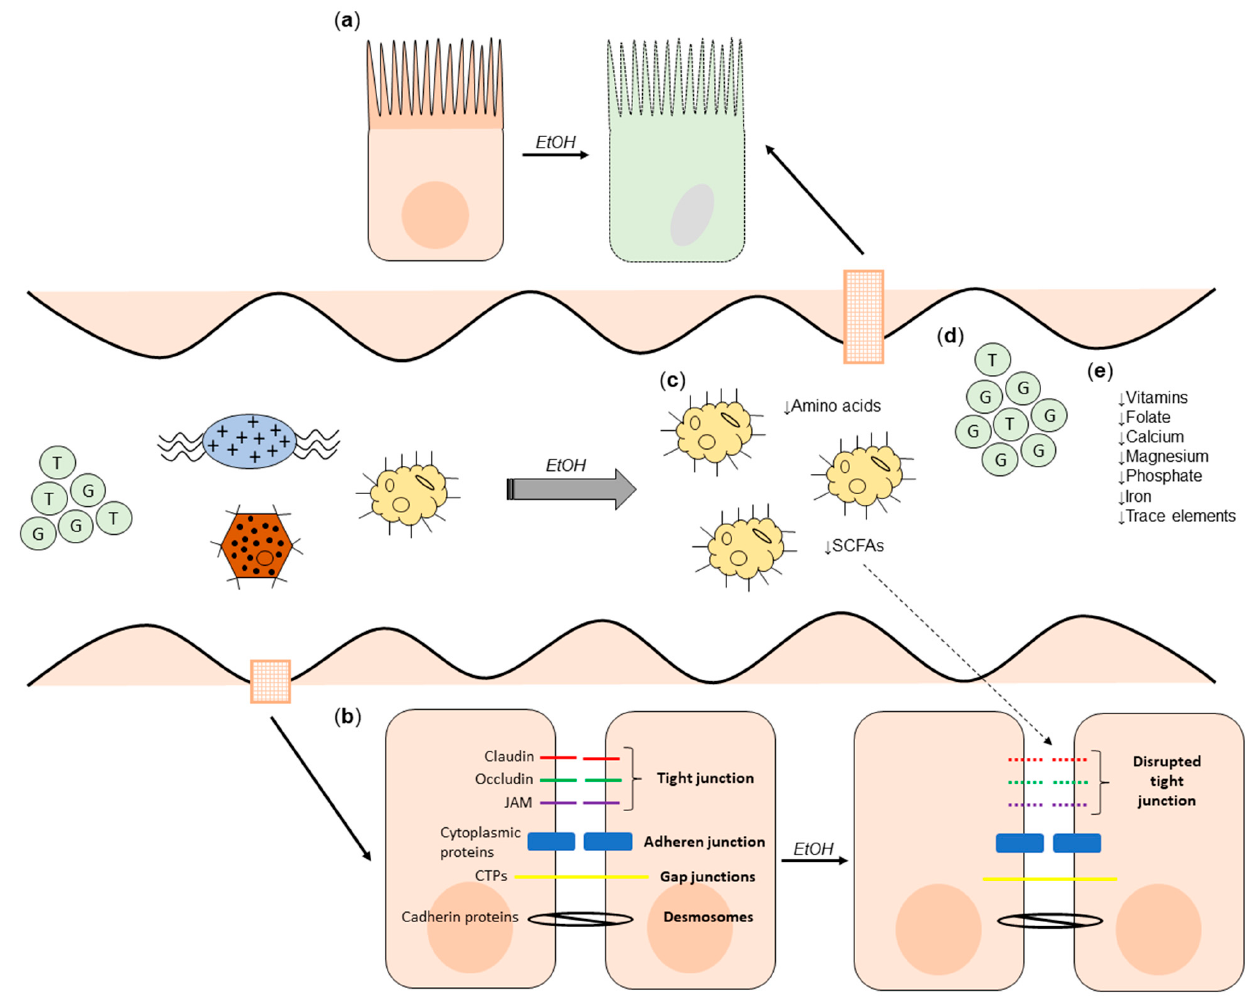
Figure 1. The effect of alcohol on the gut. ( a ) The histological effects of alcohol on the gut mucosa (cell death, mucosal erosions and loss of epithelium at villi tips). ( b ) Alcohol-induced disruption of tight junctions, exacerbated by reduced luminal SCFA concentrations. ( c ) Alcohol-induced dysbiosis leading to reduced SCFA and amino acid concentrations. ( d ) Increased concentration of secondary bile acids, and increased proportion conjugated with glycine. ( e ) Nutrient deficiencies as a consequence of ( a – d ). CTP: Connexin transmembrane proteins; JAM: Junctional adhesion molecule; EtOH: alcohol.